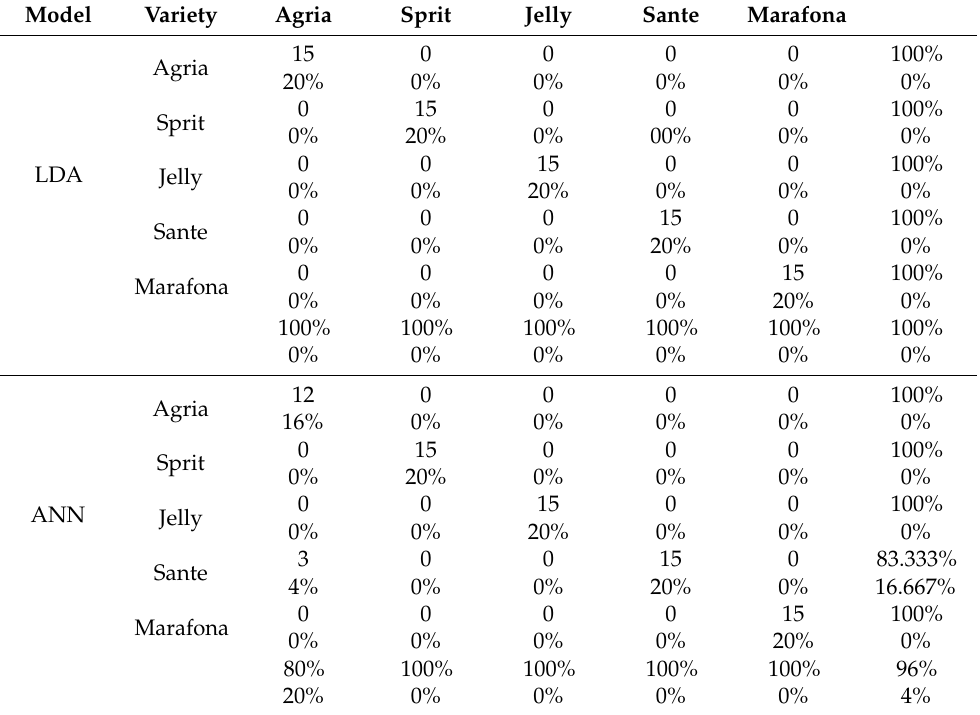
Table 3. Confusion matrix to identify five different potato cultivars using LDA and ANN methods. Model